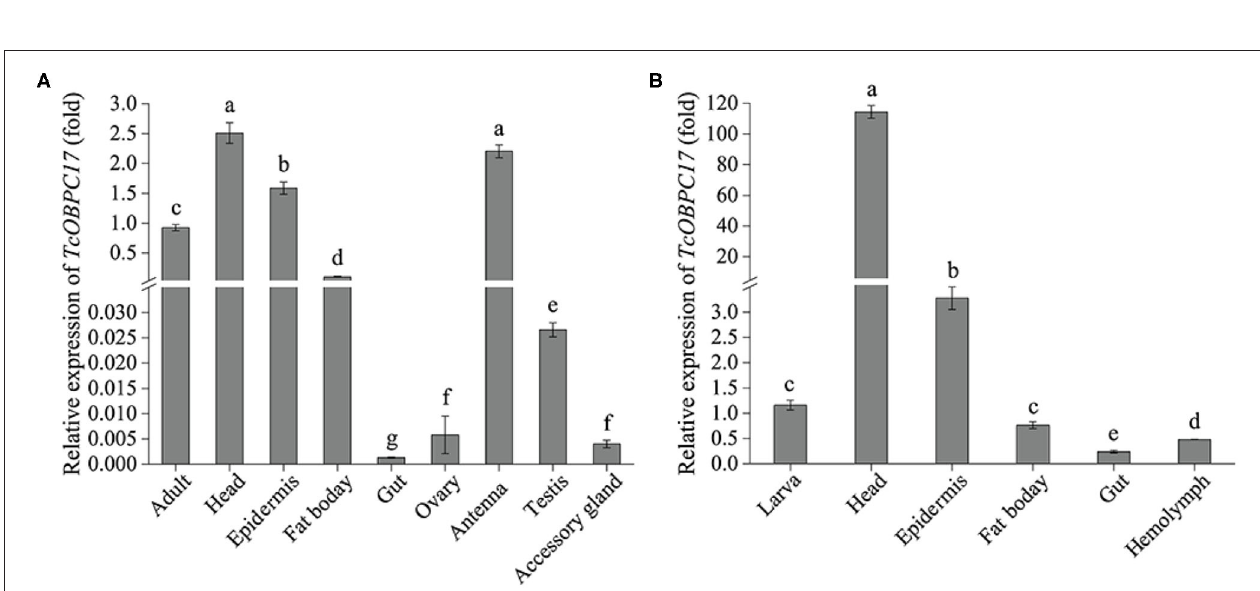
FIGURE 2 | Expression levels of TcOBPC17 in different tissues of T. castaneum late larvae and adults. (A) Expression of TcOBPC17 was measured in different tissues of T. castaneum late adults, including the whole adult, head, epidermis, fat body, gut, ovary, antenna, testis, and accessory gland. (B) Expression levels of TcOBPC17 was detected in different tissues of T. castaneum late larvae, including the whole larva, head, epidermis, fat body, gut, and hemolymph. The transcript level of TcOBPC17 in the whole adult or larva served as the calibrator of tissue-specific expression profile. The bars represent standard errors of the means ( n = 3). After logarithmic processing of TcOBPC17 levels, significant differences were subjected to Fisher’s LSD test. Different letters above the bars represent significant differences in means at P < 0.05.